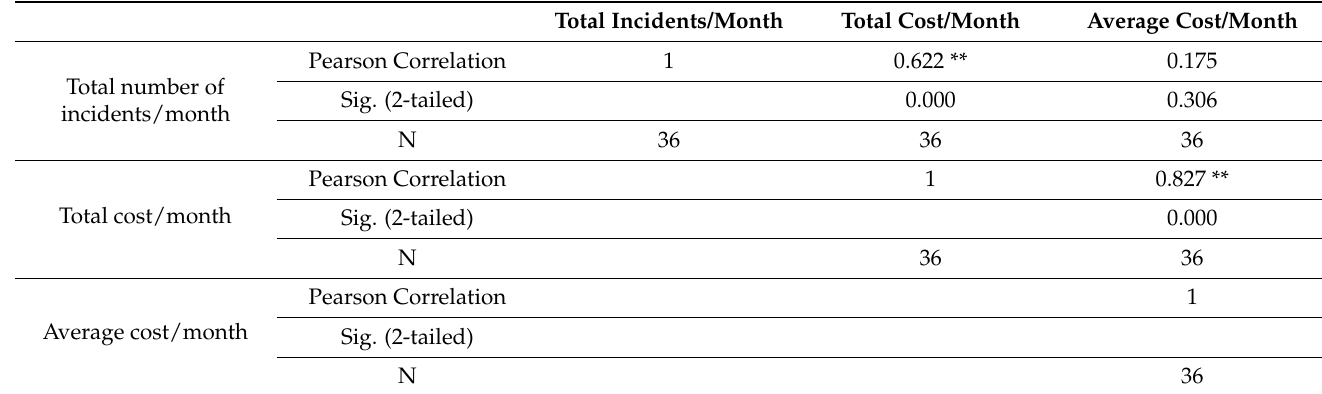
Table 5. Pearson Correlation coefficients.